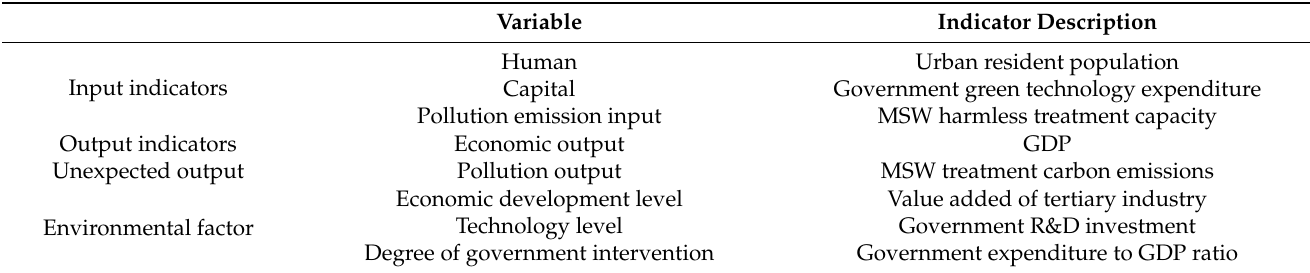
Table 1. Variable